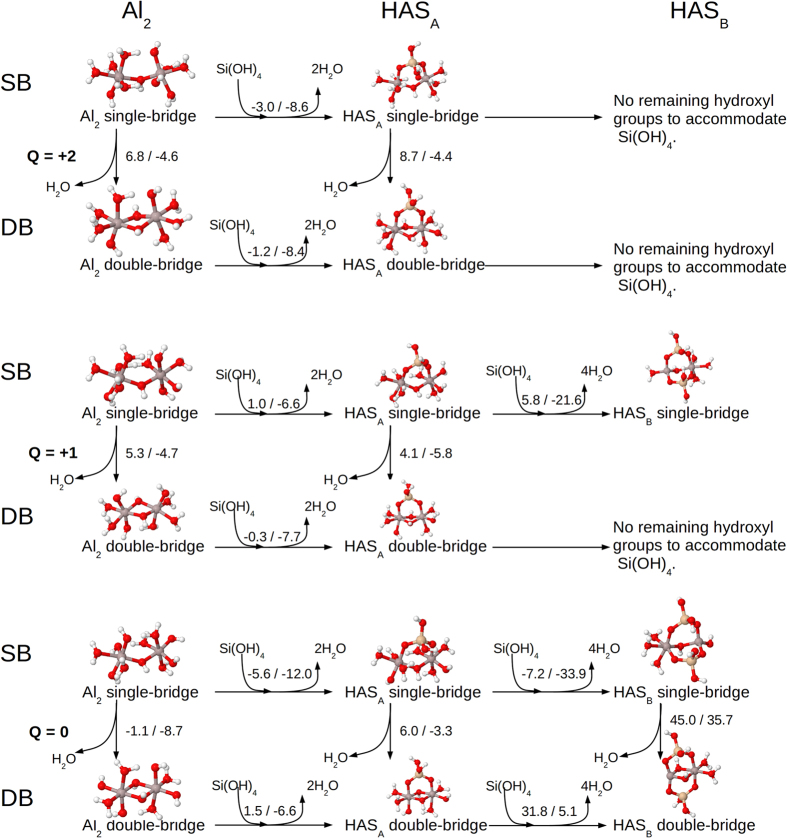
Enthalpies and free energy changes (ΔHaq/ΔGaq) for transitions between the most stable Al hydroxide dimer, HASA unit, and HASB unit of each charge and bridge-type.Units are in kcal/mol.